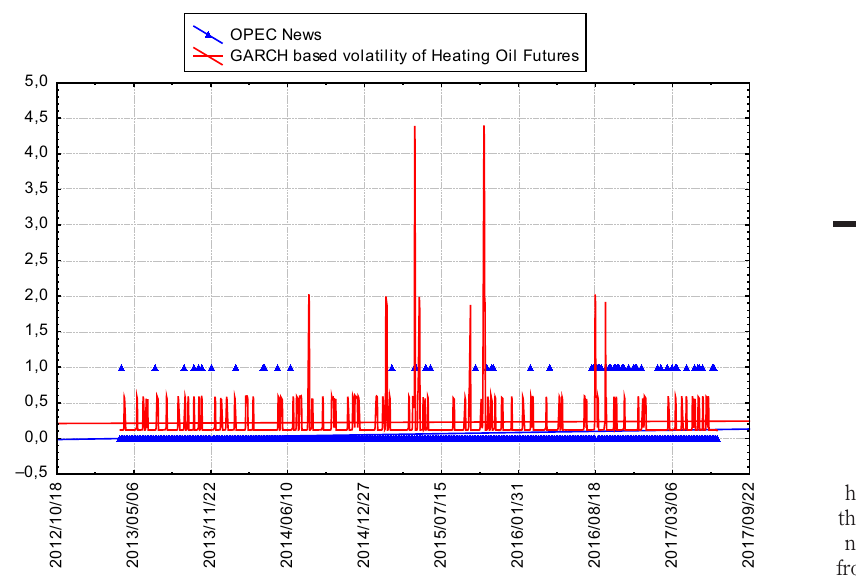
Figure 12. The conditional volatilities of the heating oil futures in the presence of OPEC news over the period from April 01, 2013